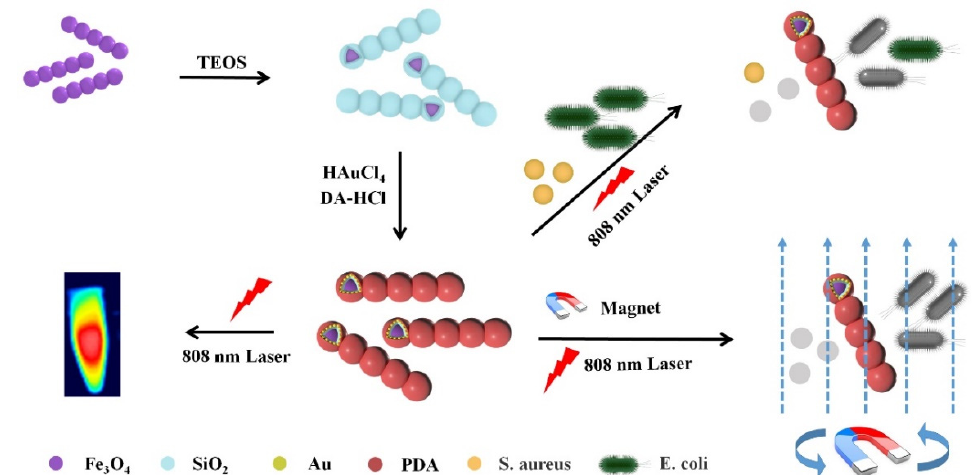
Figure 1. SEM ( a ) and TEM ( b – d ) images of Fe 3 O 4 @SiO 2 @Au/PDA nanochains.